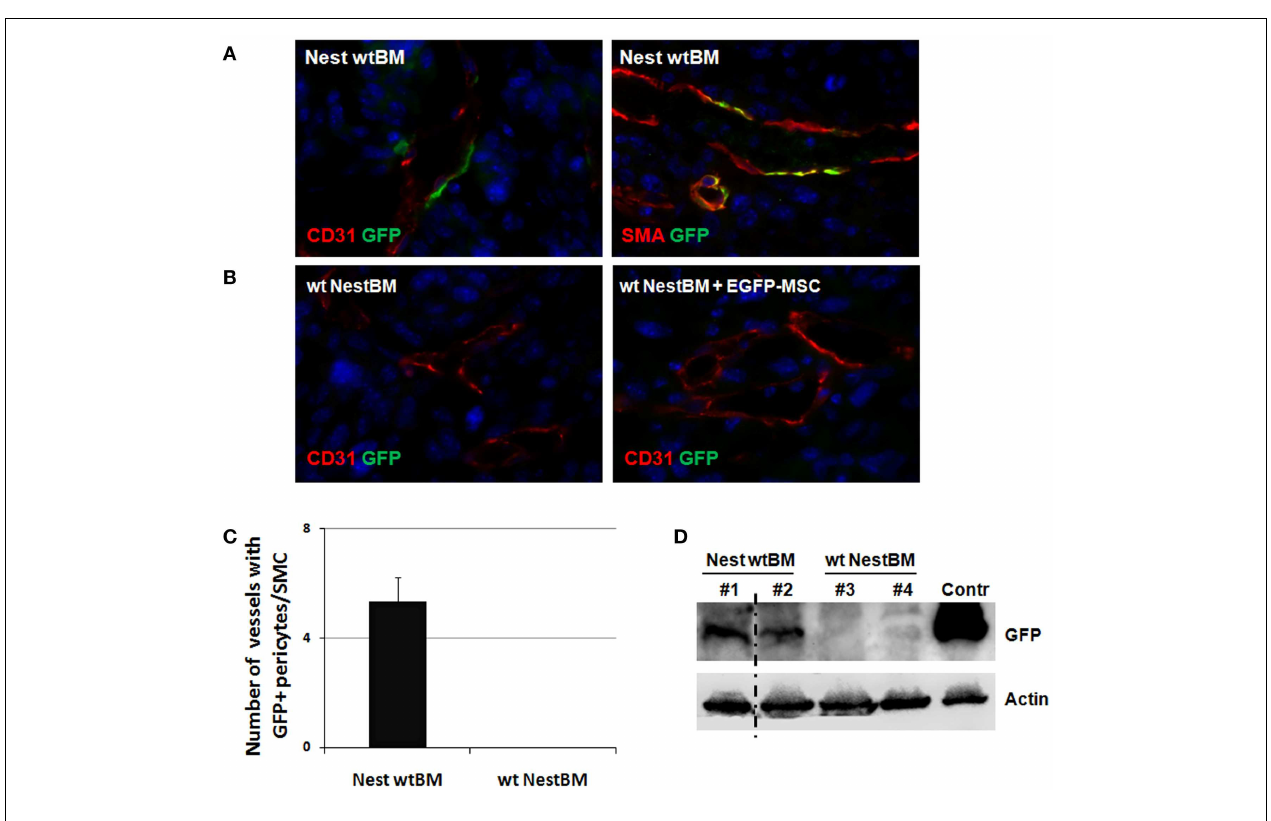
confirm that tissue-resident MSCs and not BM-derived MSCs contribute to vascular remodeling processes one group of irradiated animals received NestBM for hematopoietic reconstitution that was supplemented with BM-derived EGFP-labeled MSC. Control sections were stained with isotype controls. Scale bar 20 µ m. (C,D) GFP-expression was quantified by counting GFP